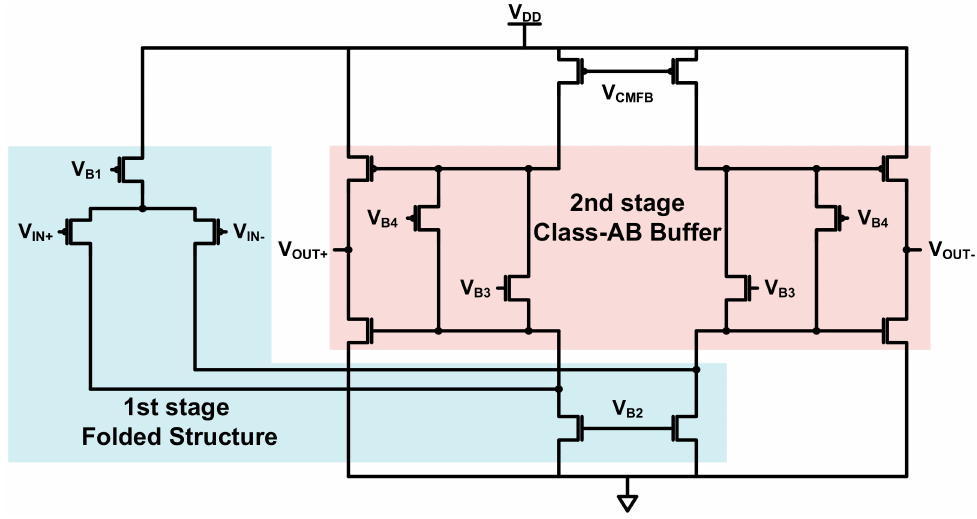
Figure 11. Folded structure and class-AB